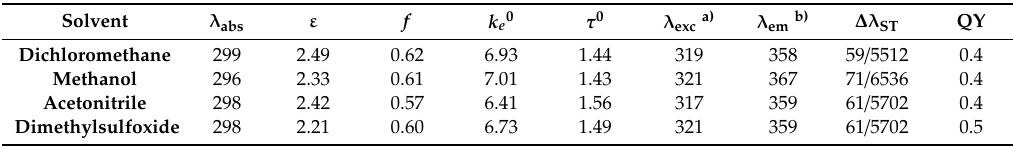
Table 2. Photophysical data of compound 7 from UV-Vis absorption, steady-state fluorescence emission, and excitation spectroscopies.